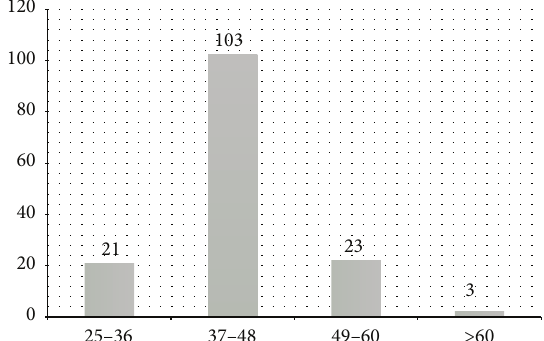
Figure 1: Age distribution of patients diagnosed with uterine leiomyoma in Pernambuco (Brazil) from 2001 to